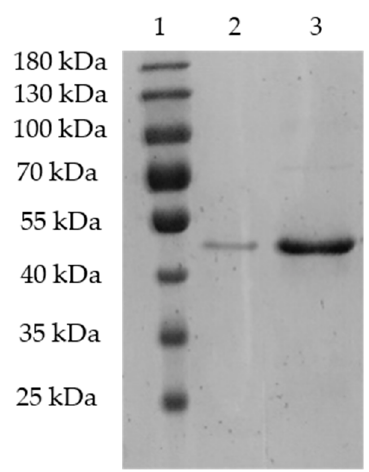
Figure 1. The SDS-PAGE of purified recombination Xyl88. Lane 1: protein molecular weight marker; lane 2: the purified recombination rXyl88 with 10-fold dilution, and lane 3: the purified recombination rXyl88.